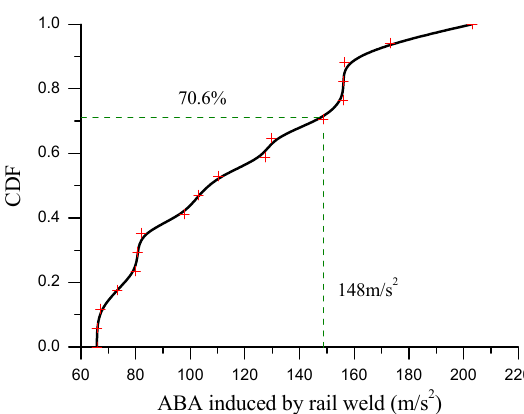
Figure 6. Cumulative distribution function (CDF) of 17 measured ABAs induced by rail welds.